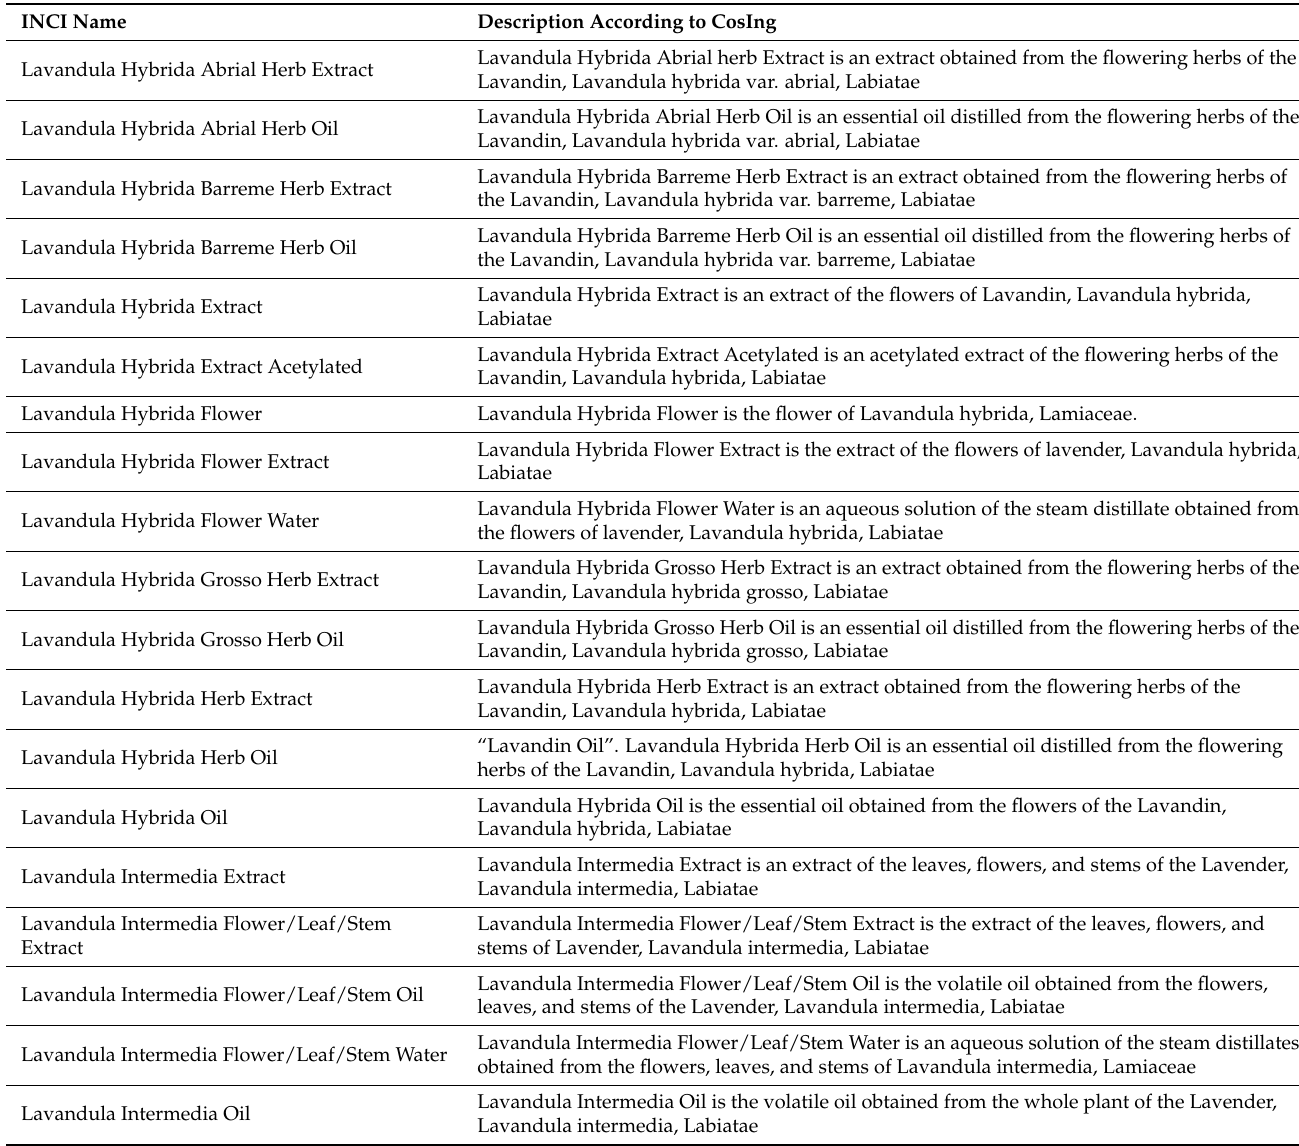
Table 5. List of official lavandin raw INCI names